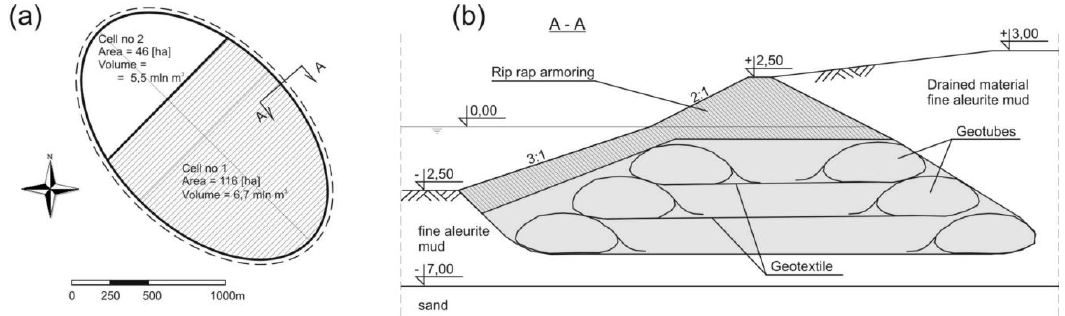
Figure 2. Project of the confined disposal facility (CDF) in the Vistula Lagoon; plane view ( a ) and cross-sectional view ( b ) [4].